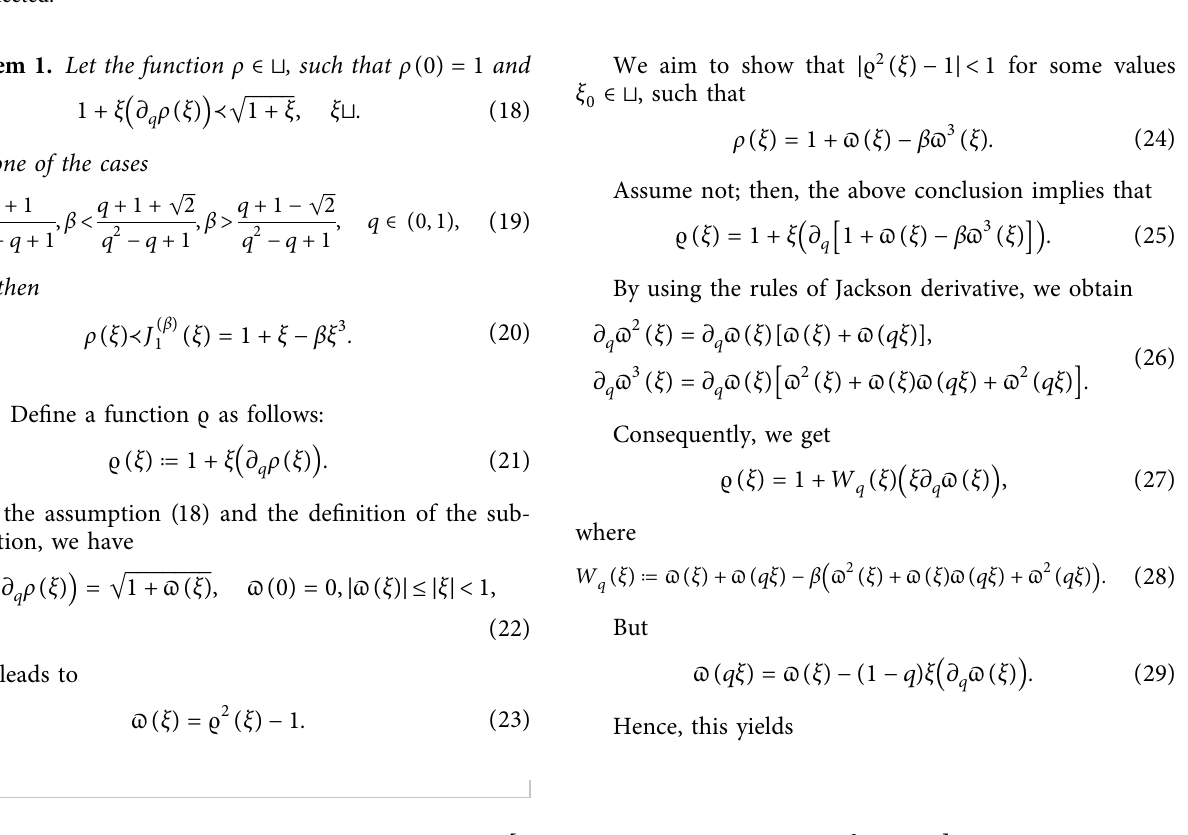
,i � 1 , 2 , 3 for β � 1/2 , 1/3 , 1/4 and β � 1, respectively. The plot is connected when β ∈ ( 0 , 1 ] ; otherwise, it is i